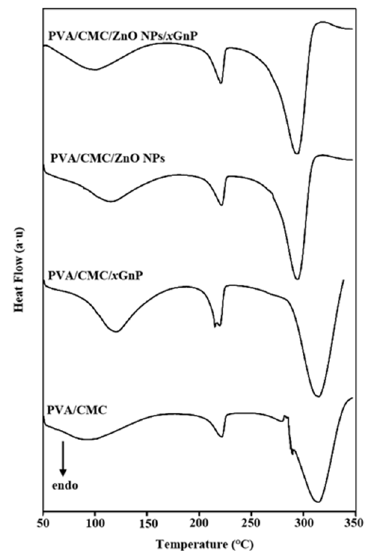
Figure 6. DSC (Differential Scanning Calorimetry) thermograms of pure PVA/CMC, PVA/CMC/ x GnP, Figure 6. DSC (Di ff erential Scanning Calorimetry) thermograms of pure PVA / CMC, PVA / CMC / x GnP, PVA/CMC/ZnO NPs and PVA/CMC/ZnO NPs/ x GnP (ZnO NPs: x GnP = 7:3) composite films without PVA / CMC / ZnO NPs and PVA / CMC / ZnO NPs / x GnP (ZnO NPs: x GnP = 7:3) composite films ultrasonication. without ultrasonication. Table 1. The values of T g and T m of pure PVA / CMC, PVA / CMC / x GnP, PVA / CMC / ZnO NPs